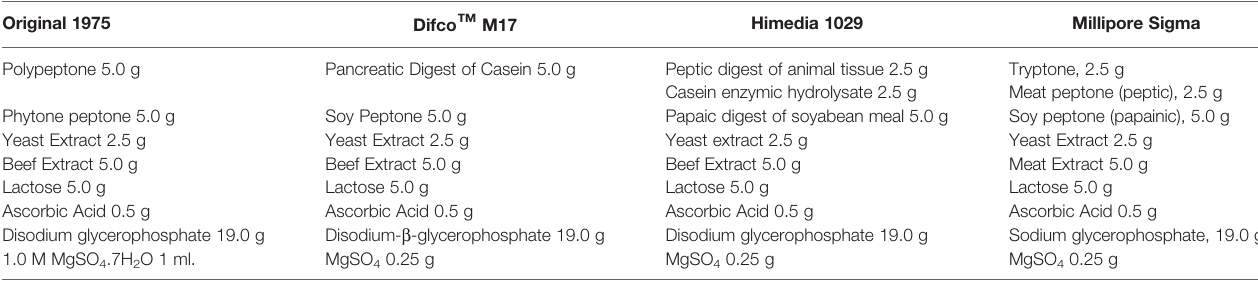
Recipe is per 950 mL before adding sterile lactose solution with the exception of Himedia in which the lactose is included in the dry powder. Tryptone is tryptic digest of casein [Trypsin cleaves peptides on the C-terminal side of lysine and arginine amino acid